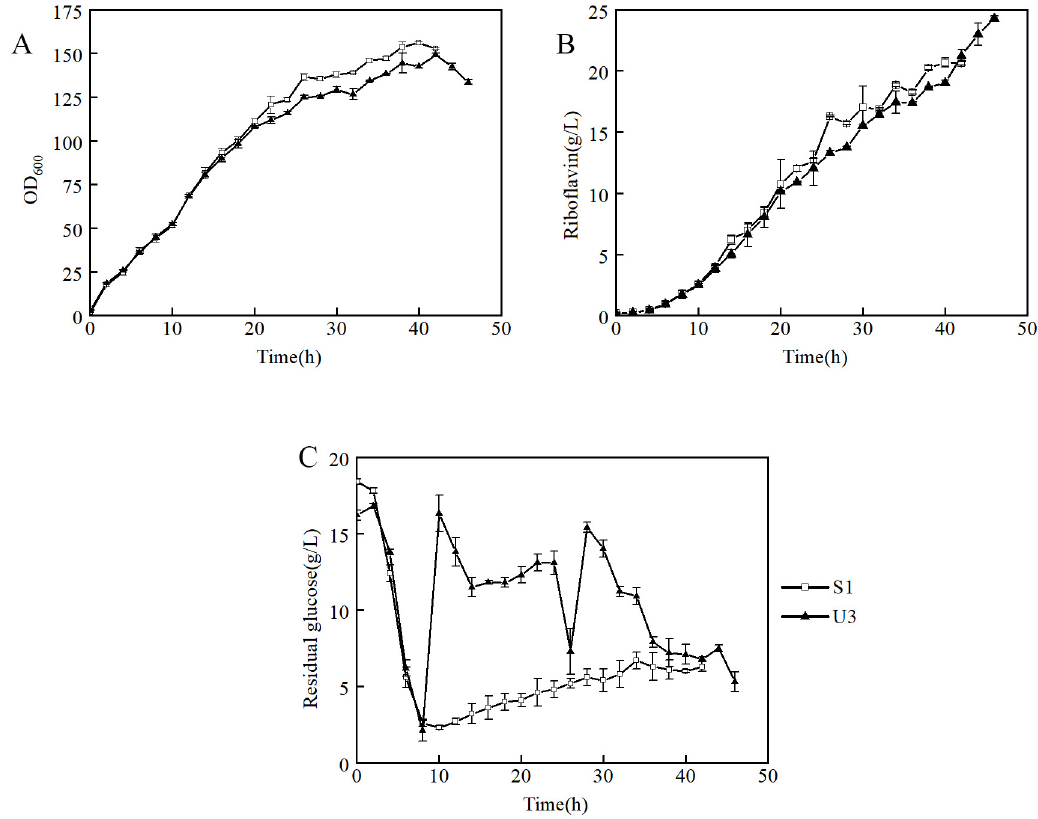
Figure 3. Fed-batch fermentation by strains S1 and U3 in a 7.5-L bioreactor containing 3 L of fer-